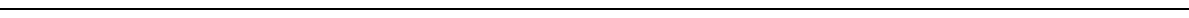
Fig. 3 L. longbeachae induces long-lasting expansion of pulmonary MAIT cells. a Flow cytometry plots showing MAIT cell percentage among TCR β + lymphocytes in the lungs of C57BL/6 mice either uninfected or infected with 10 3 , 10 4 or 10 5 CFU L. longbeachae for 7 days. Relative ( b ) and absolute ( c ) numbers of MAIT cells and conventional αβ T cells 7 days post infection. Kinetics of MAIT cells during 300 days after intranasal infection with 2 × 10 4 CFU L. longbeachae: absolute numbers ( d ), and relative percentages ( e ) of MR1-5-OP-RU tetramer + MAIT cells or conventional αβ -T cells in C57BL/6 and MR1 − / − mice. f Representative fl ow cytometry plots and g summarised data from BrdU incorporation assays to detect cellular proliferation in lung and draining lymph nodes of uninfected mice or at days 3 and 5 after intranasal infection with 10 4 CFU L. longbeachae . Percentages in brackets represent the proportion of MR1-5-OP-RU tetramer + MAIT cells with BrdU incorporation. Experiments used 4 – 6 ( a – e ) or 3 ( f , g ) mice per group (mean ± SEM) and were performed twice with similar results. Mice were infected as described above and injected i.p. with 2 mg BrdU in 200 μ l volume. After 2 h, mice were killed for T-cell preparation. Cells were stained with a cocktail of antibodies and 5-OP-RU tetramers fi rst, then permeabilised and fi xed for intranuclear DNA staining with anti-BrdU antibody. B6 C57BL/6 mice, BrdU bromodeoxyuridine, CFU colony-forming units, DPI days post infection. Statistical tests: ANOVA followed by Dunnett ’ s test: **P < 0.01, **** P < 0.0001; C all comparisons with the respective uninfected (naive) groups P < 0.0001 for Dunnett ’ s on log- transformed data. See also Supplementary fi gures 5,